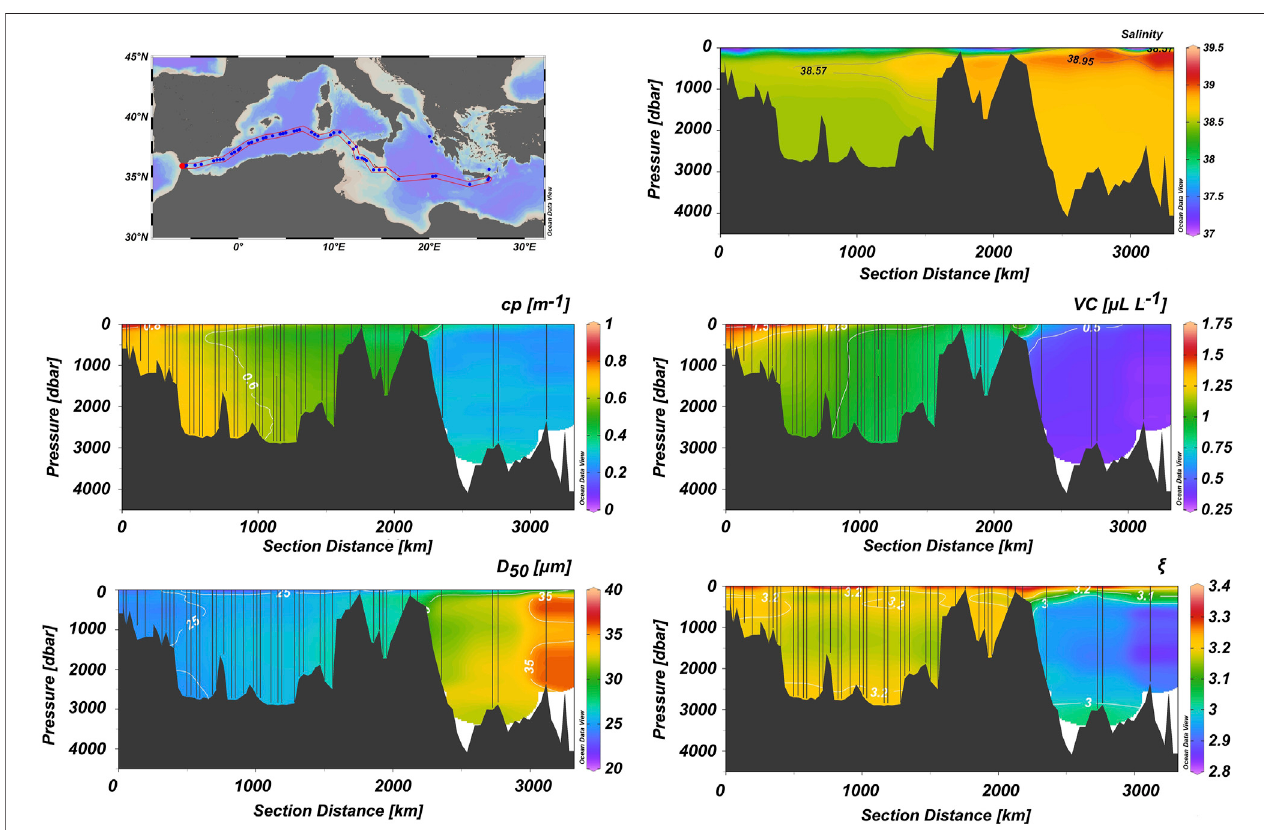
FIGURE4| West-eastsectionofsalinity,c p ,VC,D 50 and ξ intheMediterraneanSea.Section locationisshowninthe upperleft panel.Verticallinescorrespondto LISST-Deep casts.